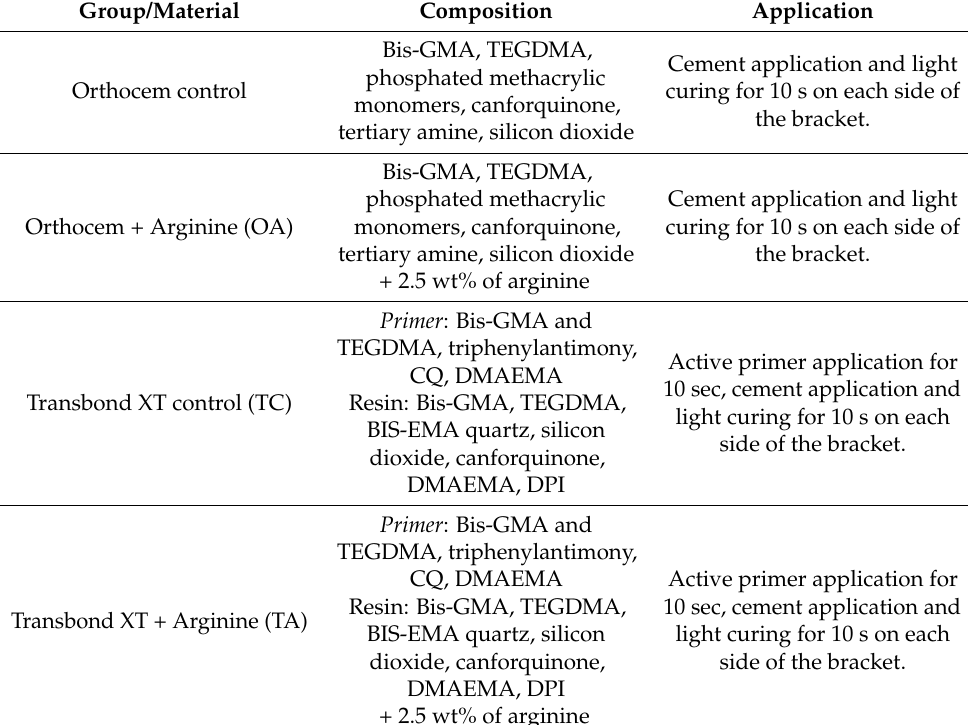
Table 1. Materials used and application methods for each group/material